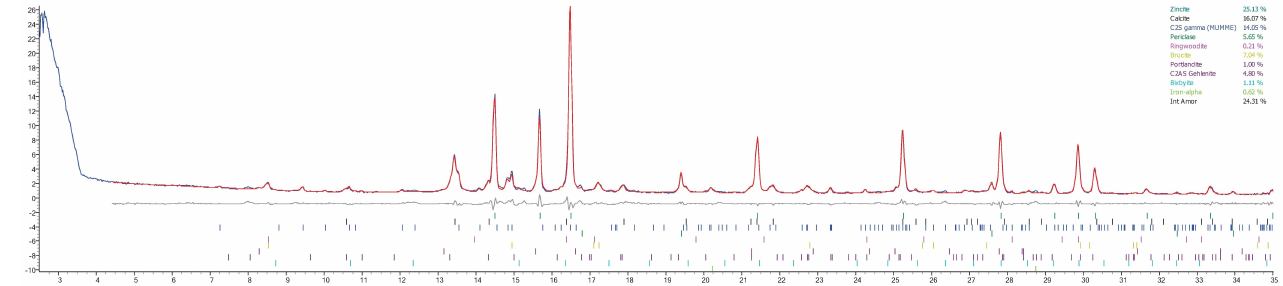
Figure 2. Results of X-ray diffraction of ladle furnace